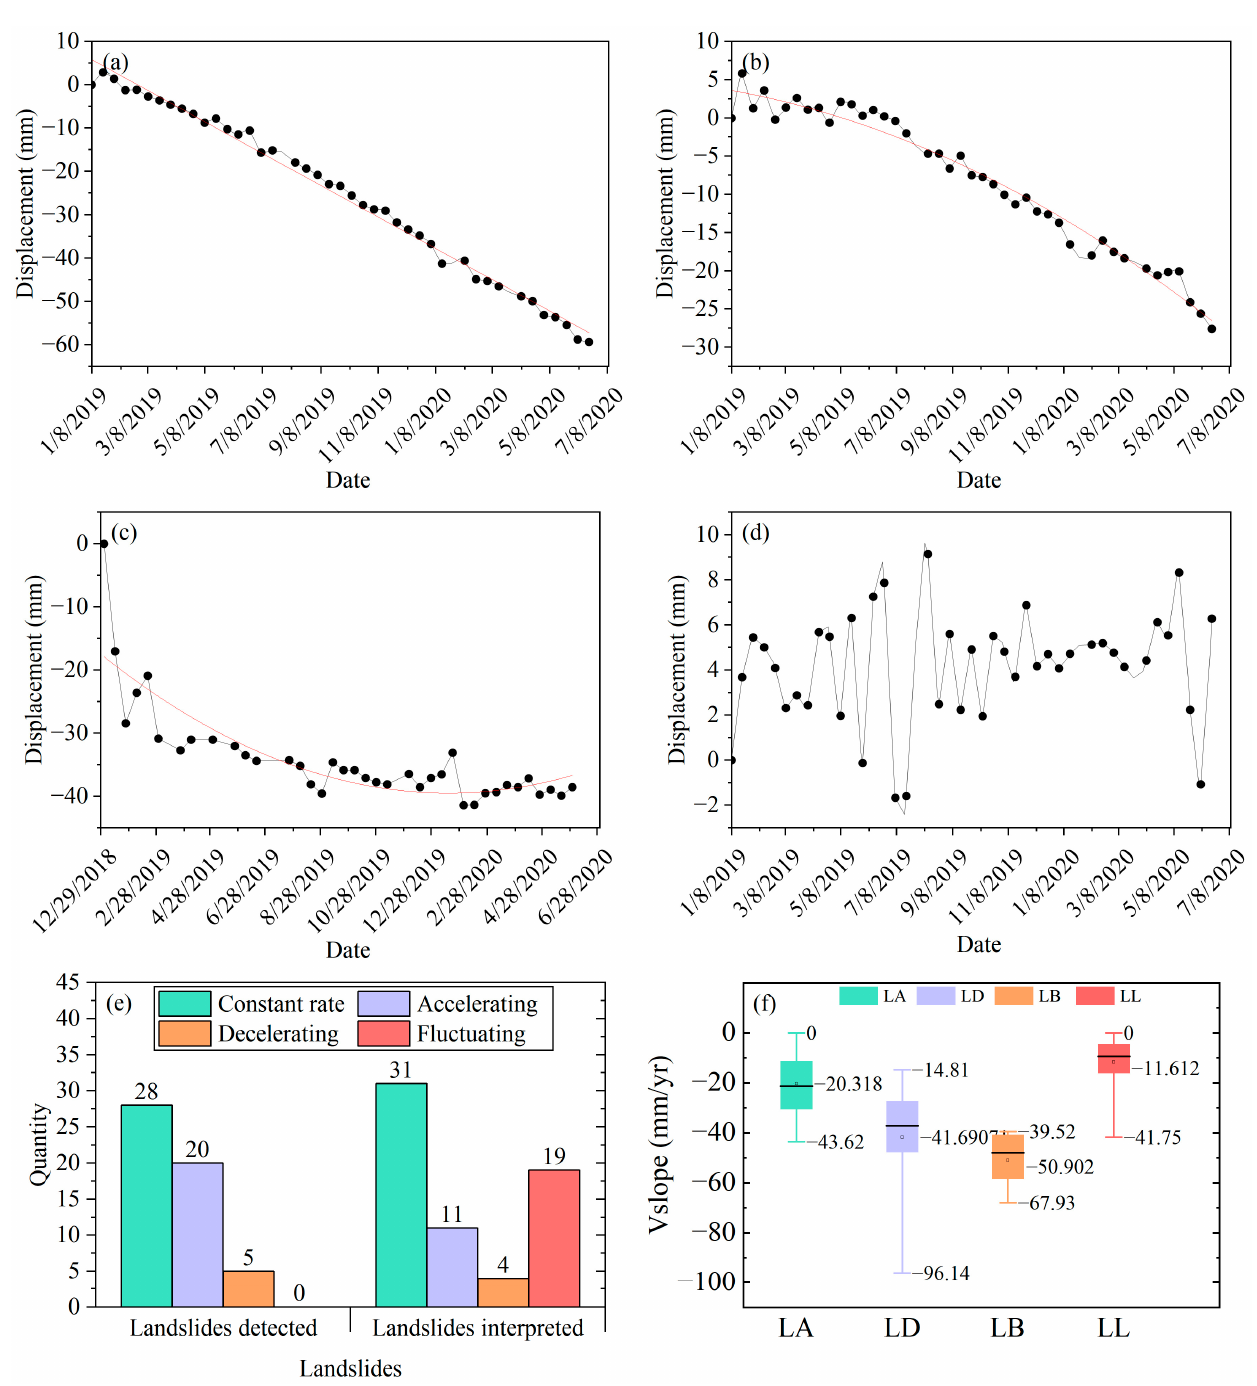
Figure 9. Typical time-series of four types of pre-failure strain. ( a ) Constant rate, ( b ) accelerating, ( c ) decelerating, and ( d ) fluctuating strains; ( e ) statistical quantity of landslides in different pre-failure strains; and ( f ) multi-source landslides development characteristics of velocity, the landslide statistic includes landslides detected by ascending (LA), descending (LD), both ascending and descending Sentinel-1A datasets (LB) and the landslides from literature (LL).